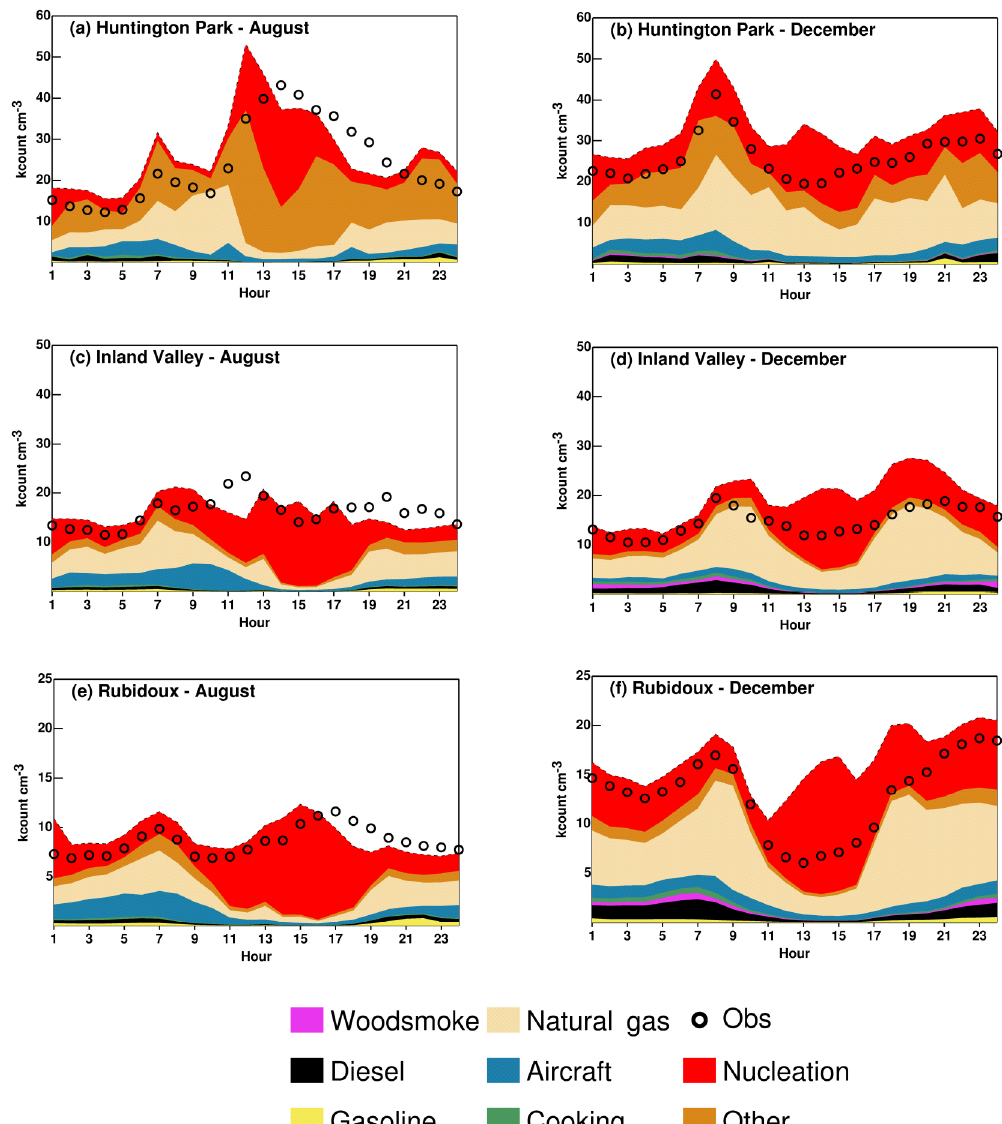
Figure 17. Diurnal variations of measured N 7 and predicted best-fit N 10 averaged for August 2011 (a, c, e) and December 2012 (b, d, f) at Anaheim, central LA, and